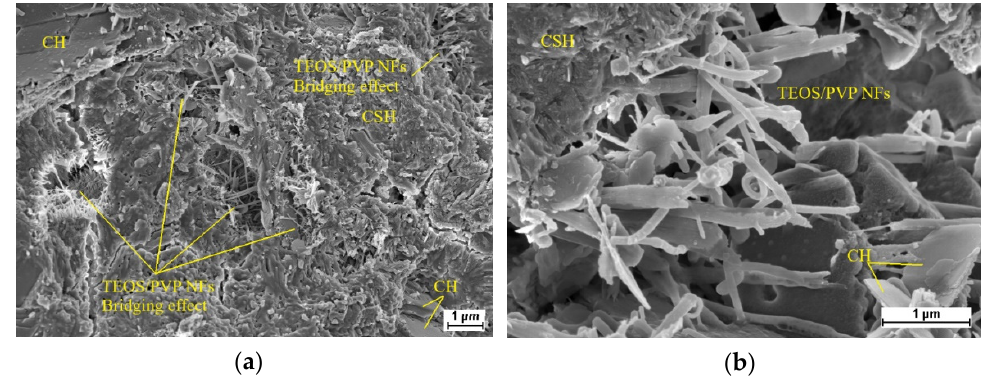
Figure 8. SEM images of cement matrix containing TEOS/PVP NFs. ( a ) magnification of 20 k, ( b ) magnification of 50 k.